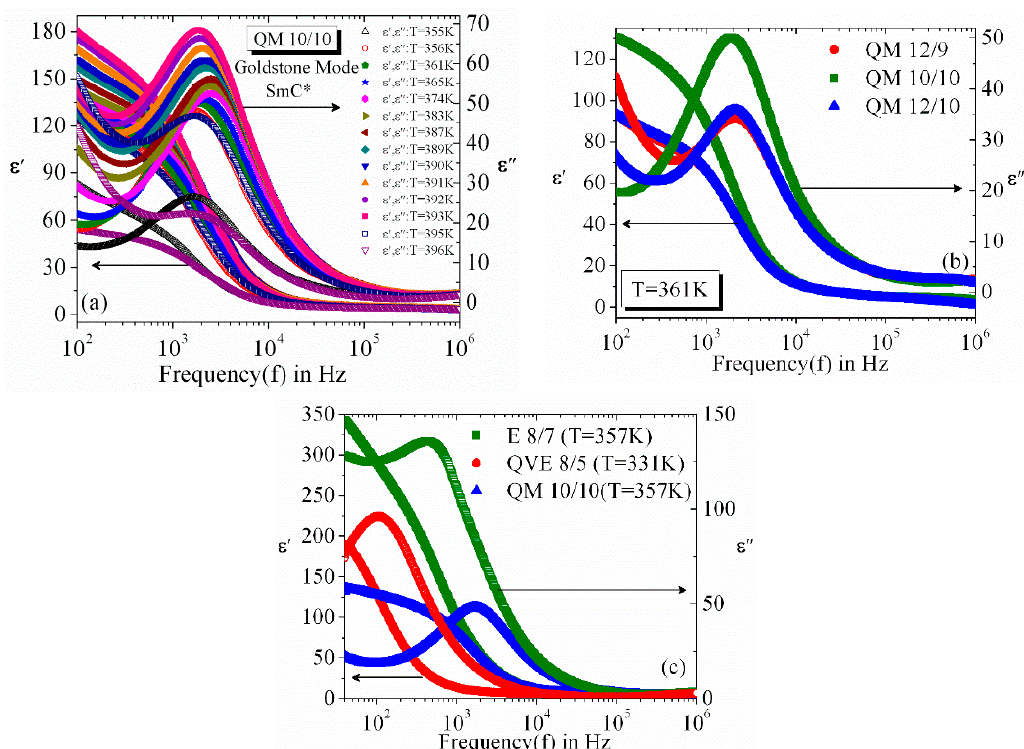
Figure 1. Frequency dependence of real ( ε ' ) and imaginary ( ε " ) part of complex permittivity in the ferroelectric SmC* phase for: ( a ) QM10/10 at different temperatures; ( b ) three of QMn/m compounds at T=361K and ( c ) three structurally different QVE8/5 (T=331K), E8/7 (T=357K), QM10/10 (T=357K) compounds.